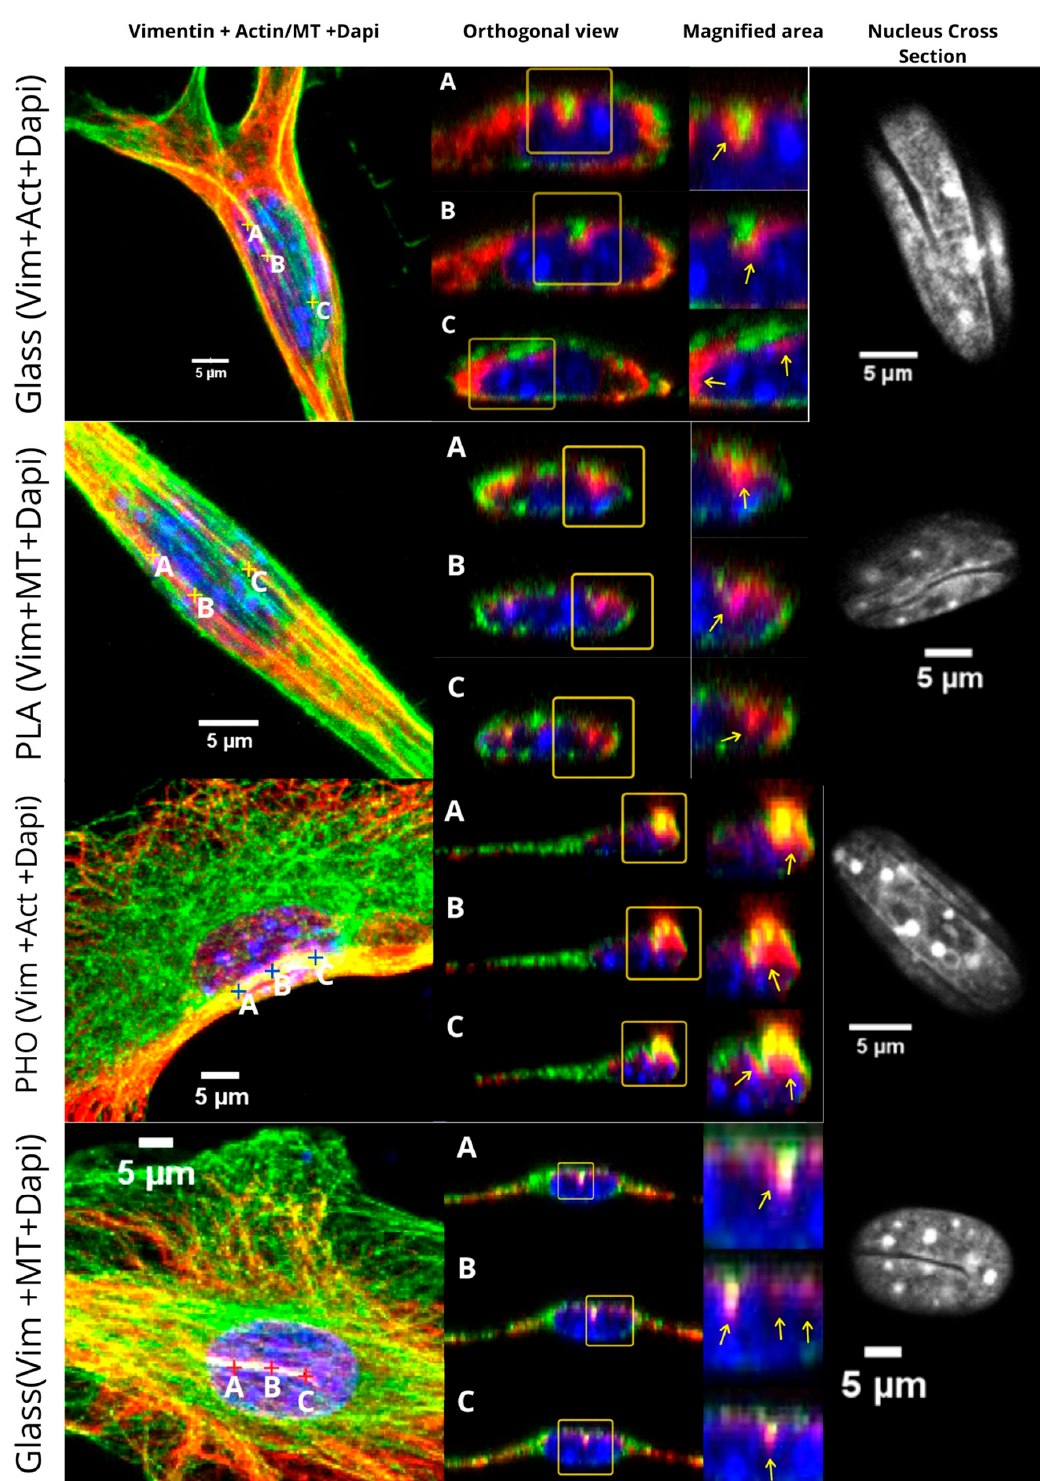
Figure 7. Comparison of grooves for selected MEF 3T3 cells, cultured on Glass, PHO, and PLA. Cells stained for actin or microtubules (green), vimentin (red), and Dapi (blue). Red, yellow and blue “+” signs (marked as A, B, C per each sub image) indicate the spots chosen for cross-section images. Yellow frames indicate the magnified areas of A, B and C spots, yellow arrows indicate the regions of interest.